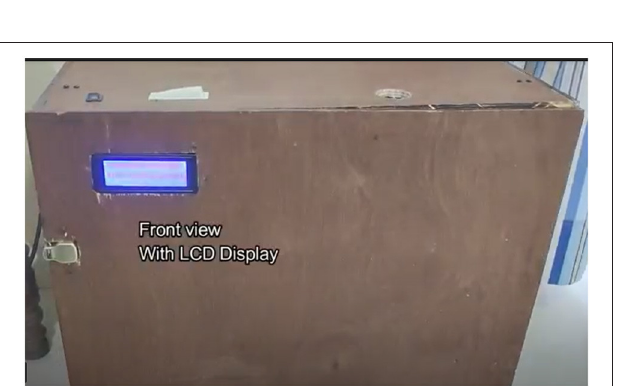
FIGURE 12 | Device front view.